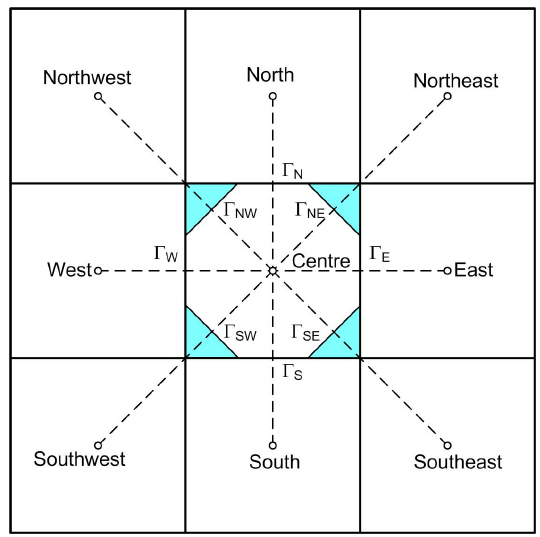
Figure 5. Eight flow directions and flow boundaries of each